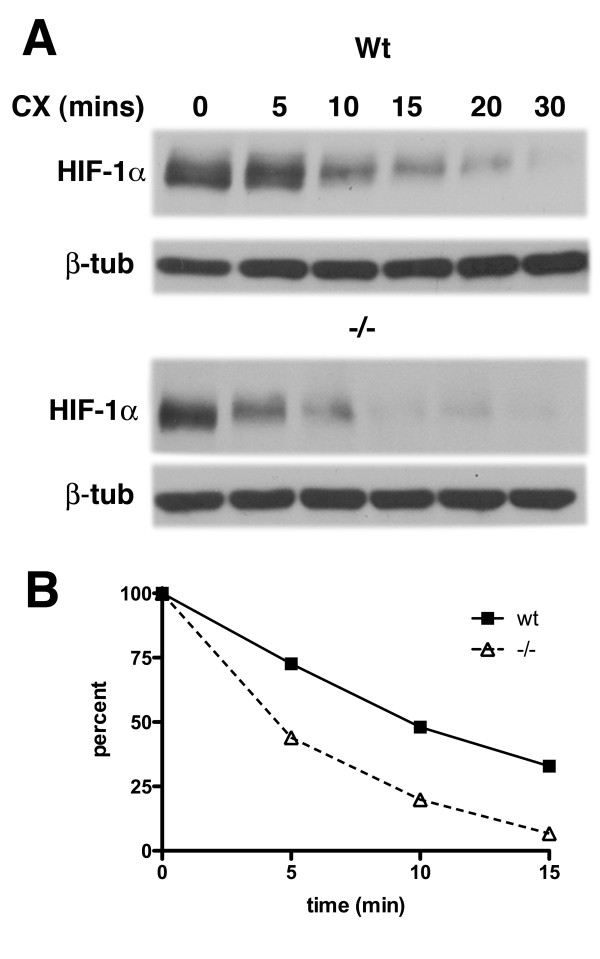
Accelerated degradation of HIF-1α in Psen1-/- fibroblasts. Psen1+/+ and Psen1-/- fibroblasts were treated with cycloheximide. In panel A, a representative experiment is shown with cells treated for the indicated times. Due to the difference in basal HIF-1α levels between Psen1 +/+ and Psen1-/- cells, total protein loaded (15 μg for Psen1+/+ and 30 μg for Psen1 -/-) and blot exposure times were adjusted so that the signal at time 0' would be of similar intensity in Psen1+/+ and Psen1-/- cells to facilitate comparison. In panel B, the % HIF-1α remaining at each time point normalized to β-tubulin is shown. Data is derived from the average of three independently performed experiments.